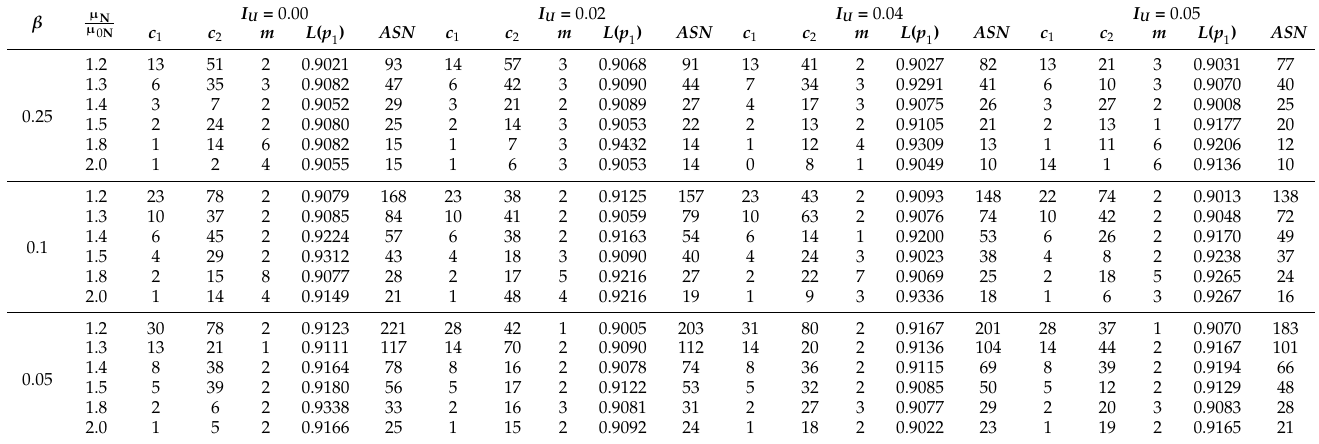
Table 9. The MDS design values for α = 0.10, ν = 3.1946, and a = 0.50.